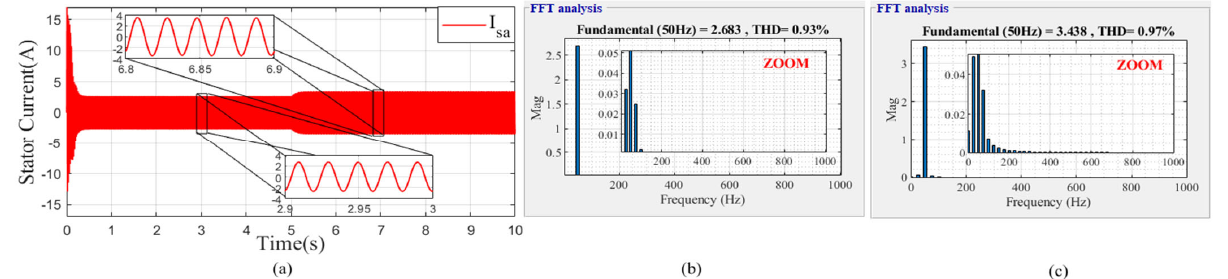
Figure 23. Performance with Cage bearing defect of IM without control: ( a ) Stator current and ( b ) THD at no ‐ load and ( c ) THD with load (5 Nm).